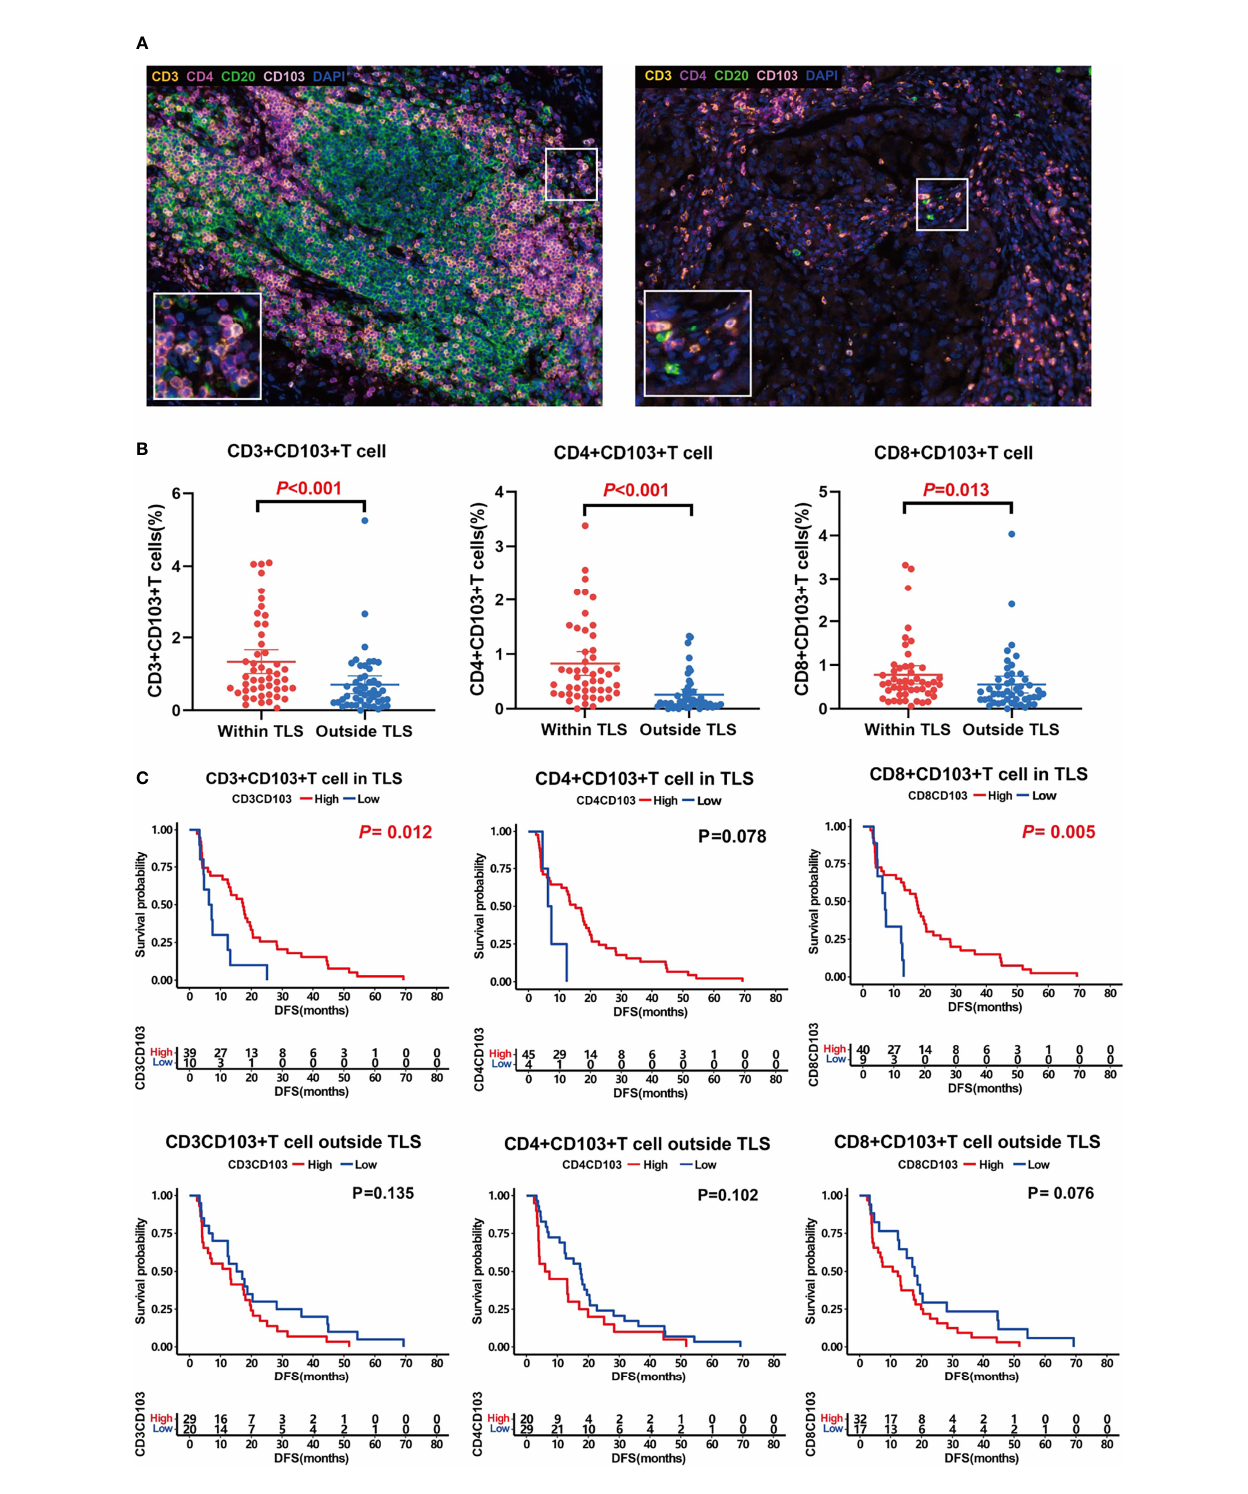
FIGURE 3 | T RM distribution and its association with prognosis. (A) Representative images of T RM inside (left) and outside (right) TLSs. (B) Comparison of CD3 + CD103 + T RM (left, P < 0.001), CD4 + CD103 + T RM (middle, P < 0.001), and CD8 + CD103 + T RM (right, P < 0.001) distribution inside and outside TLS. T RM were mainly located in TLS. C, In fl uence of T RM inside and outside of TLS on patient prognosis. T RM inside TLS predicted a better